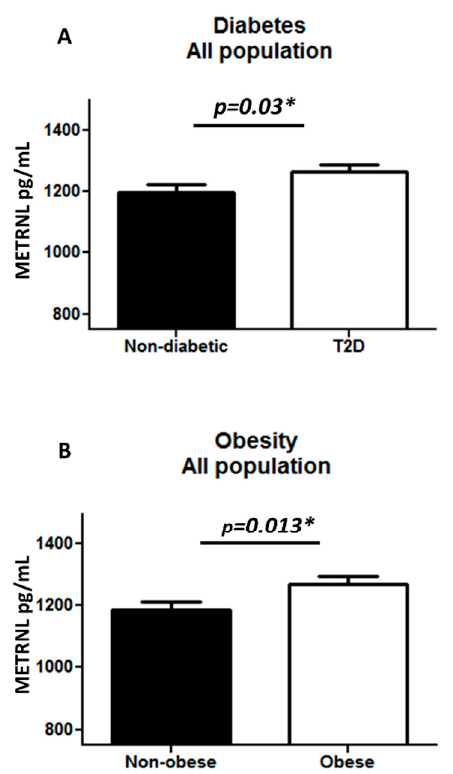
Figure 1. Meteorin-like hormone (METRNL) level in plasma in all populations (n = 228). ( A ) Comparing non-diabetic to T2D individuals; ( B ) comparing non-obese to obese individuals. The METRNL level in plasma was determined using enzyme linked immunosorbent assay (ELISA). The population was classified on the basis of their diabetic status ( A ). Diabetes was defined by fasting plasma glucose ≥ 126 mg / L (7 mmol / L). Furthermore, the population was classified on the basis of obesity ( B ). Obesity was defined based on BMI, where participants with BMI > 30 kg / m 2 were considered obese and those with BMI between 20 and 30 kg / m 2 were considered non-obese. Statistical assessment was 2-sided and considered statistically significant at * p < 0.05.